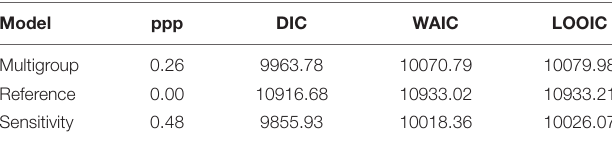
Smallest values for information criteria indicate preferred